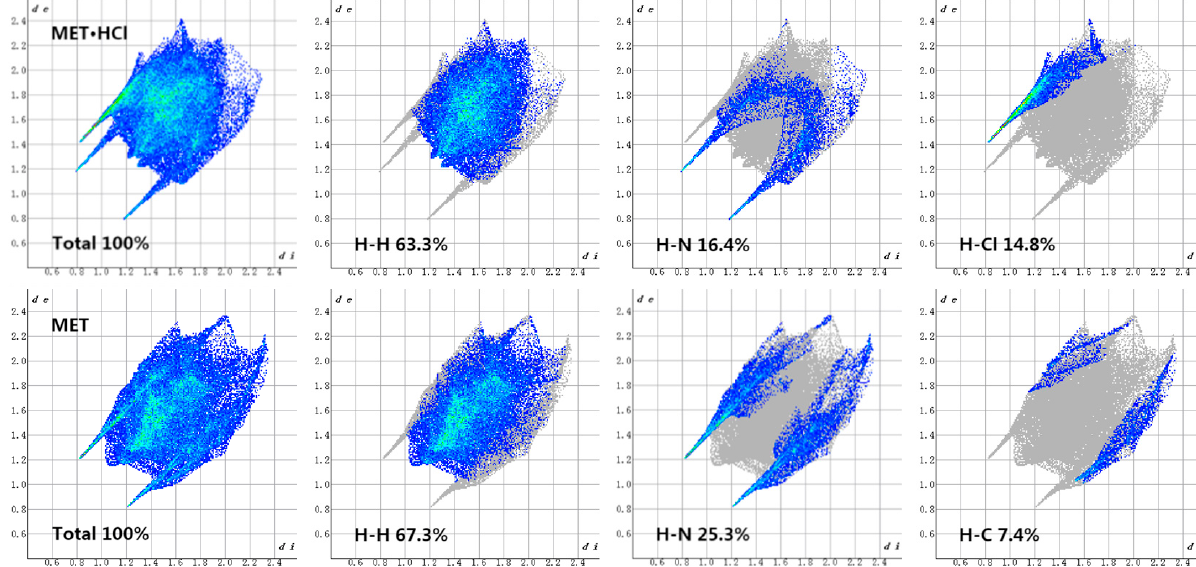
Figure 14. Highlight close contacts from H atom to H, N, Cl, and C atoms in the 2D fingerprint plots of MET in MET·HCl and single component of MET.